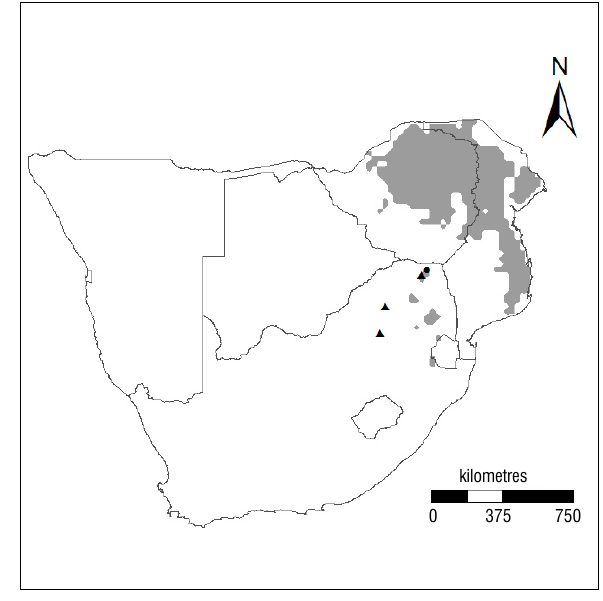
Source: Adapted from White’s 9 map of African vegetation. Figure 1: Distribution of miombo woodland in Africa.